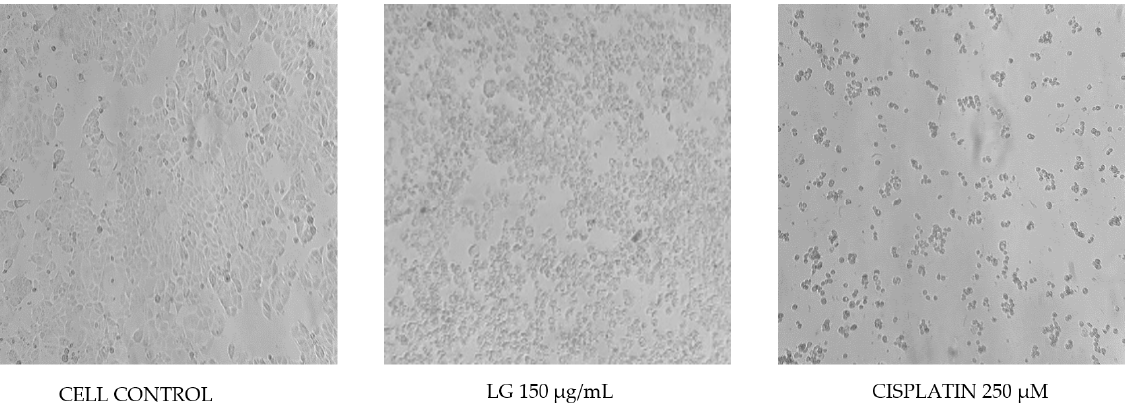
Figure 6. MCF-7 cells exposed to different treatments during 72 h incubation. Cell control represents cells without treatment. Images obtained under the microscope (40×).